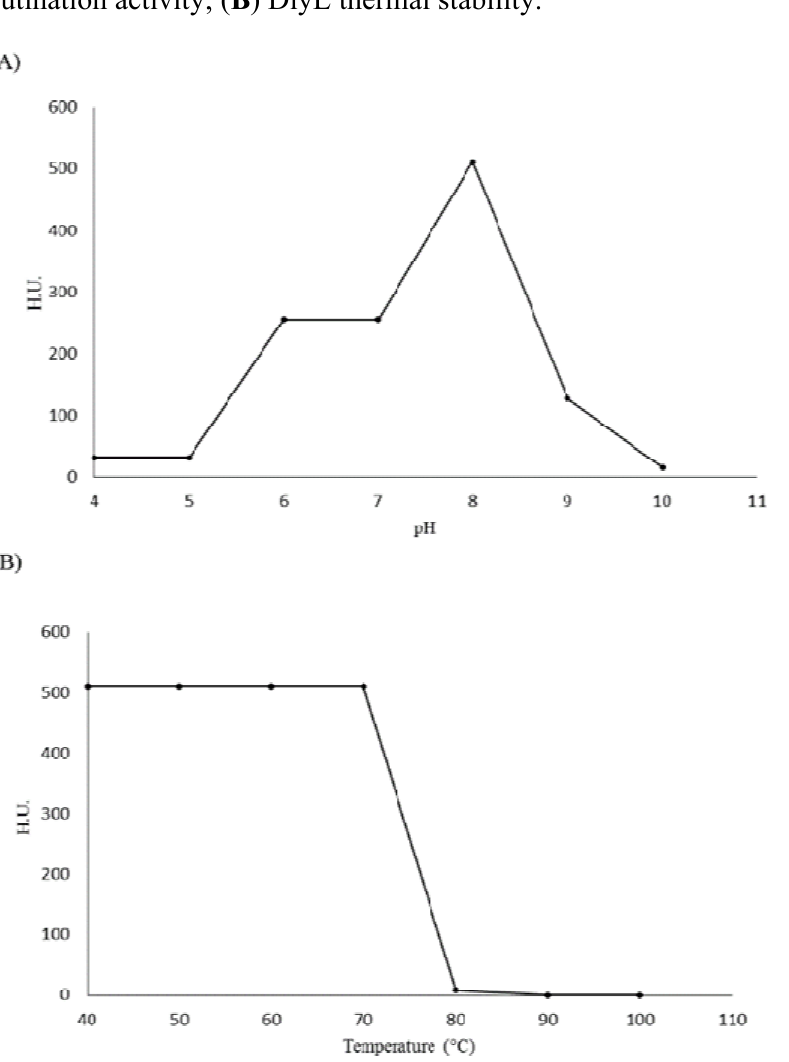
Figure 3. Physicochemical properties from Dioclea lasiophylla lectin. ( A ) Effect of pH on DlyL hemagglutination activity; ( B ) DlyL thermal